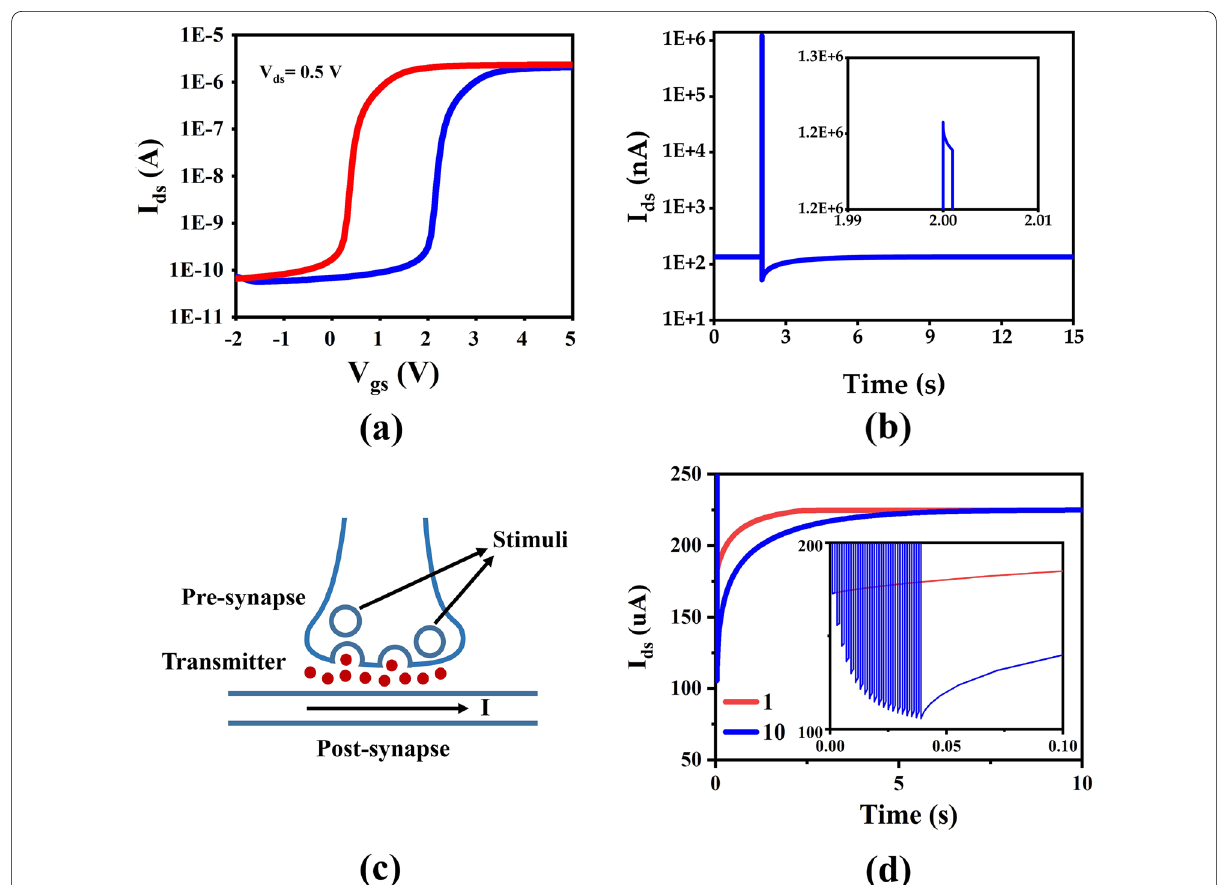
Fig. 2 a Transfer characteristic of GAA InAs NW FET at V ds device. The inset shows a particle enlarged view. c Schematic illustration of the mimicking of a biological synapse. d Post-synaptic current (PSC) of the device with different numbers of presynaptic spikes (1.5 V, 1 ms) at V ds